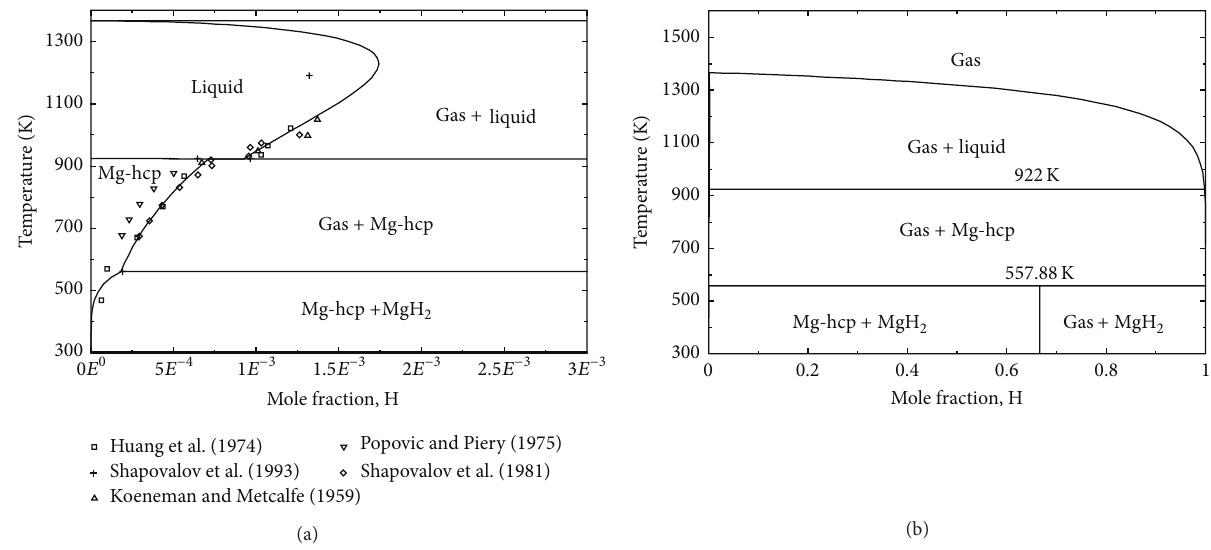
Figure 1: Calculated Mg-rich part of Mg-H phase diagram at 1 bar compared with experimental hydrogen solubilities in solid magnesium data from literature (a) and the calculated Mg-H phase diagram over the entire temperature range (b) at 1 bar.